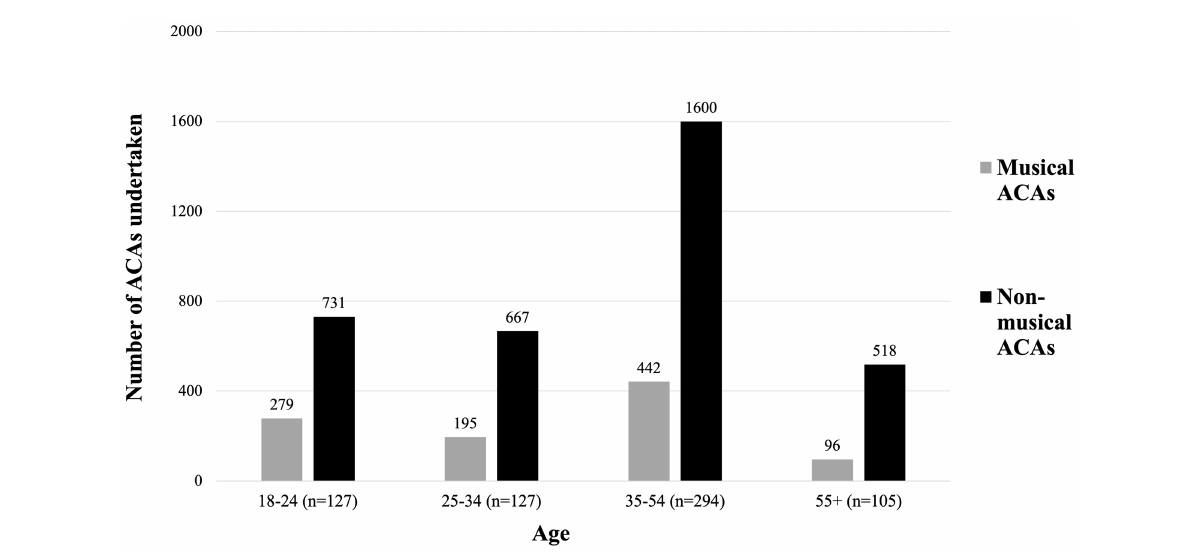
FIGURE 1 Count of undertaken ACAs across the four age groups. ACAs are split into (1) Music related ACAs, and (2) All other ACAs (i.e., those not related to